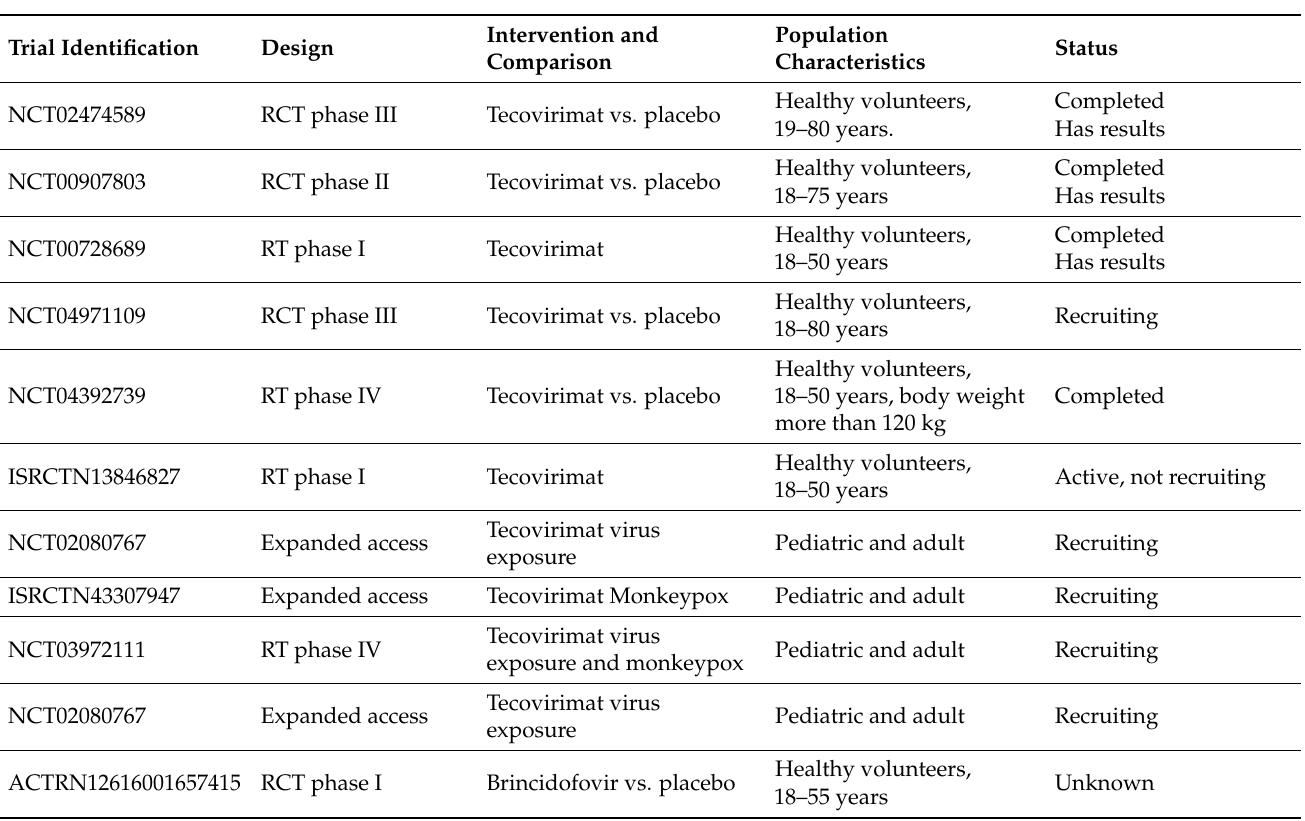
Table 2. Various drugs under clinical